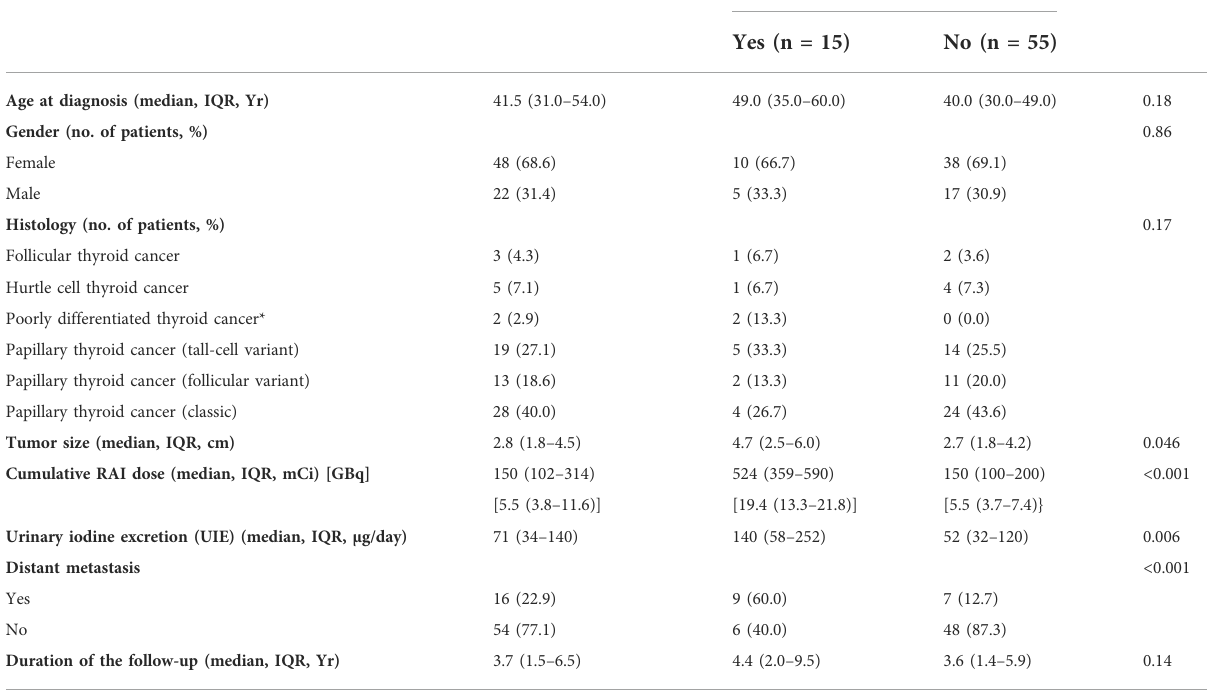
TABLE 1 Baseline characteristics of the study